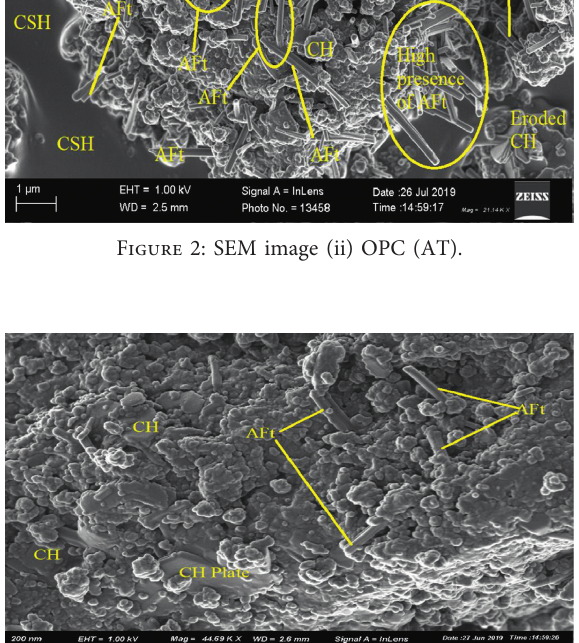
Figure 3: SEM image (iii) PPC (H